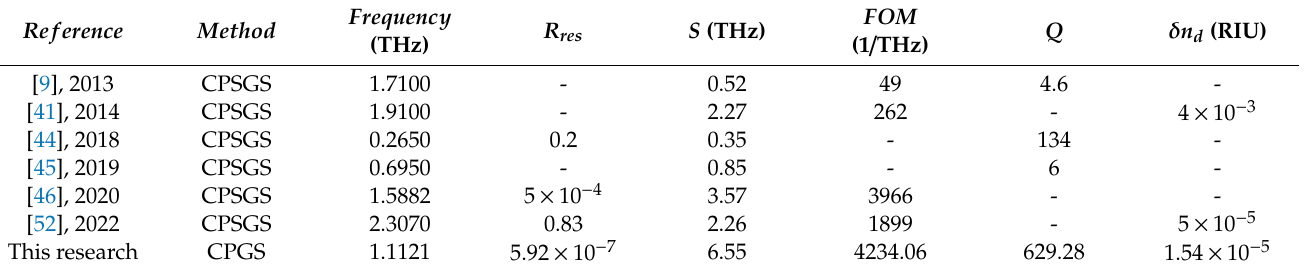
Table 3. Comparison of the sensing performance of THz-SPR sensors based on CPGS and